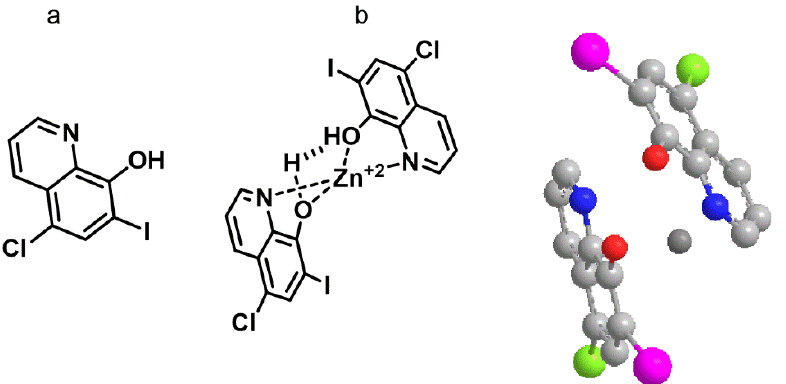
Figure 4. Structure ( a ) and three-dimensional study ( b ) of Clioquinol, 5-Chloro-7-iodo-8-quinolinol. Light grey balls represent carbon atoms. Blue balls represent nitrogen atoms. Non linked dark grey balls represent zinc cations. Red balls represent oxygen atoms. Purple balls represent iodine atoms. Green balls represent chlorine atoms.